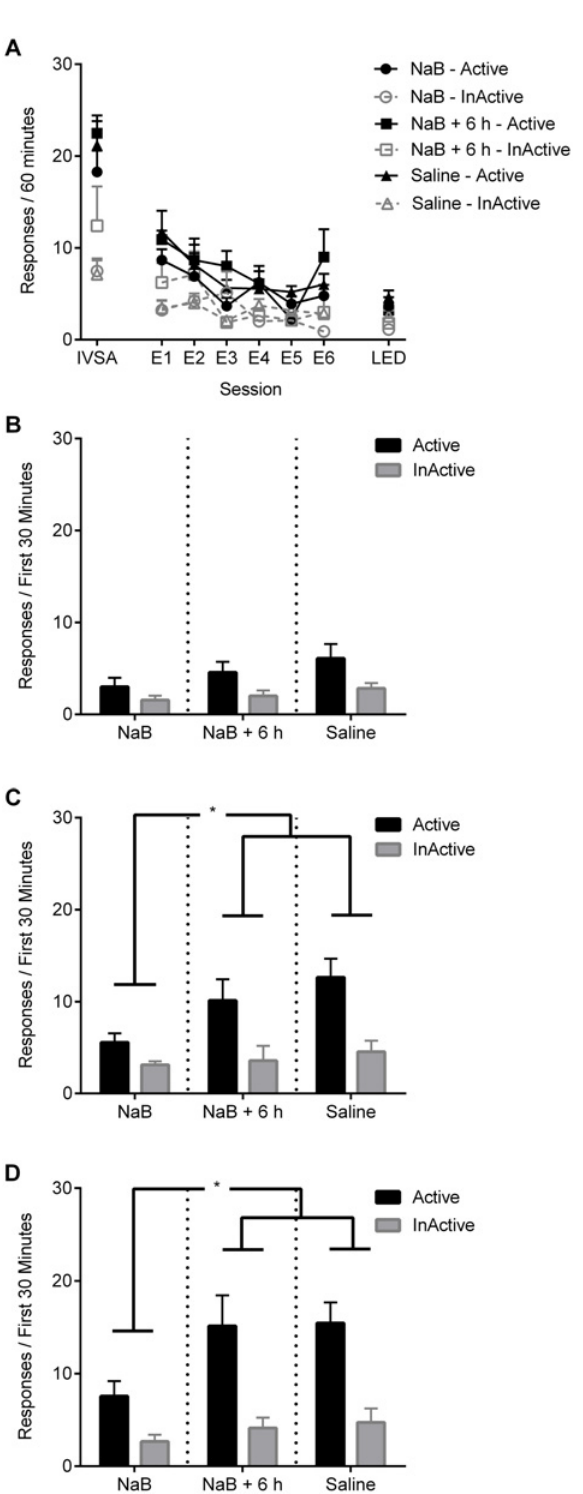
Fig 2. Experiment 1: NaB administered immediately, but not six hours, following extinction sessions attenuates reinstatement of nicotine-seeking. (A) Active and inactive responses during intravenous nicotine self-administration (IVSA; average of the last 3 sessions) as well as the first six days (E1 – E6) and last day (LED) of extinction for rats treated with sodium butyrate (NaB; n = 9), saline (n = 11), or